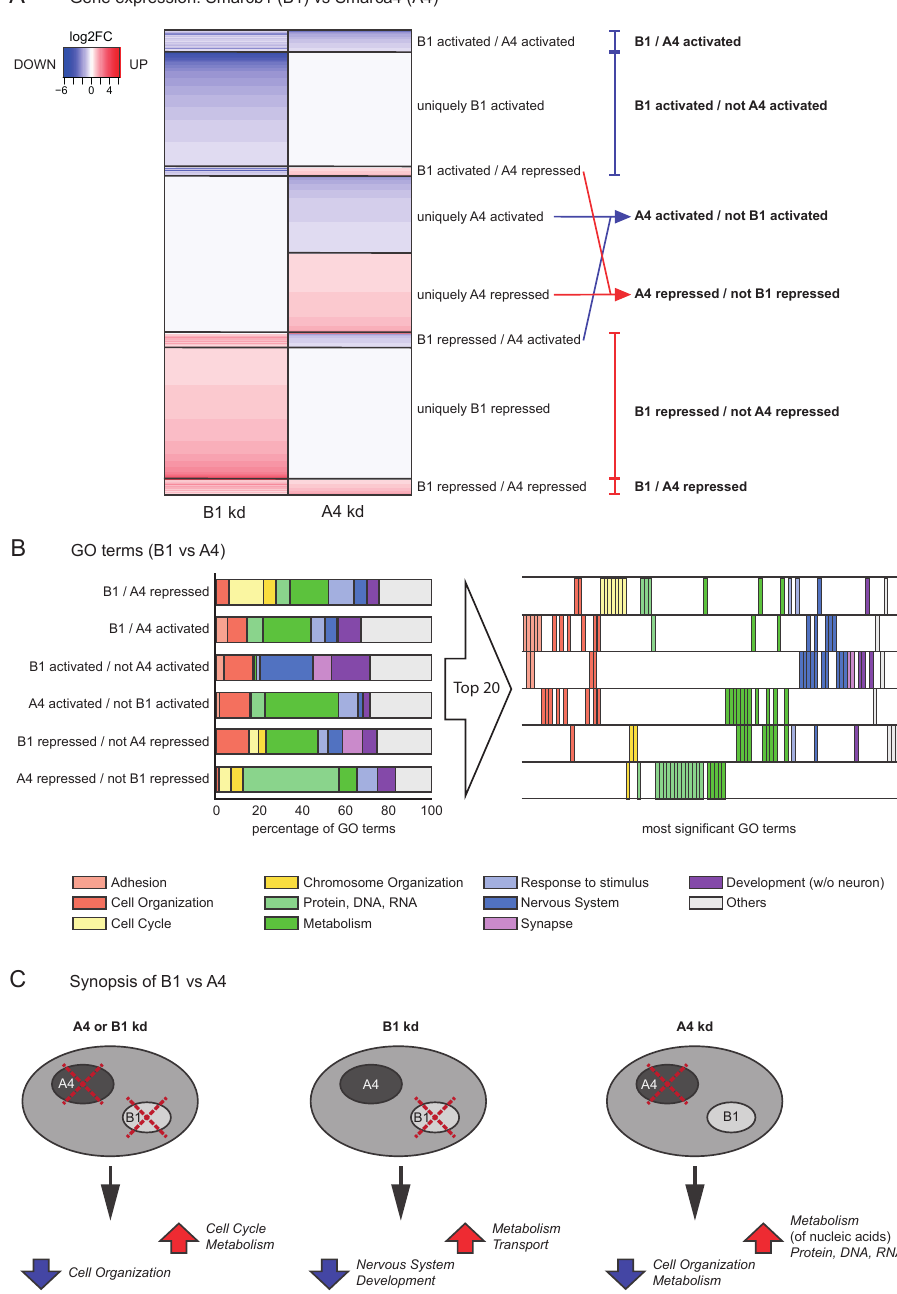
Figure 2. Comparison of gene expression after Smarcb1 and Smarca4 knockdown reveals differences between esBAF core components ( A ) Heatmap comparing gene expression data from our kd dataset ( Smarcb1 kd, 72 h) versus data obtained from Ho et al. (Ho et al., 2011) ( Smarca4 kd, 72 h). Only genes with p < 0.05 and an abs. log2FC > 0.58 in at least one dataset were included. Genes with p > 0.05 and/or an abs. log2FC < 0.58 are displayed in white, upregulated genes in red, downregulated genes in blue. Genes were further subclassified by their expression, as indicated in the figure. Group definition was set spaciously to include genes that show limited expression changes after short term kd (72 h) but are of relevance for cells’ function. Thresholds for log2FC were set according to Supplementary Table S1 ( B ) GO terms assigned to genes belonging to groups defined in ( A ). Left-hand part summarises GO-term classification into categories, right-hand part only includes GO terms within the top 20 (ordered by p value) in at least one dataset. ( C ) Synopsis of our findings concerning gene expression changes after Smarca4 or Smarcb1